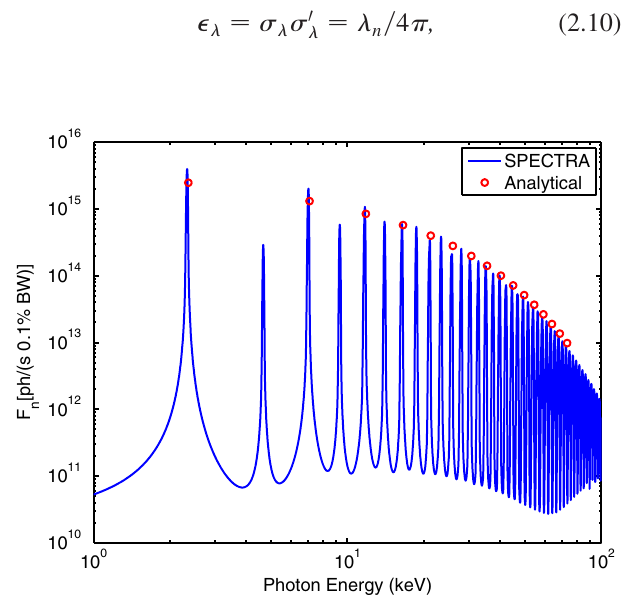
FIG. 3. Photon spectral flux in a 0.1% bandwidth calculated using SPECTRA [48] within the forward cone of 3 (cid:5) 0 formula [Eq. (2.3)].